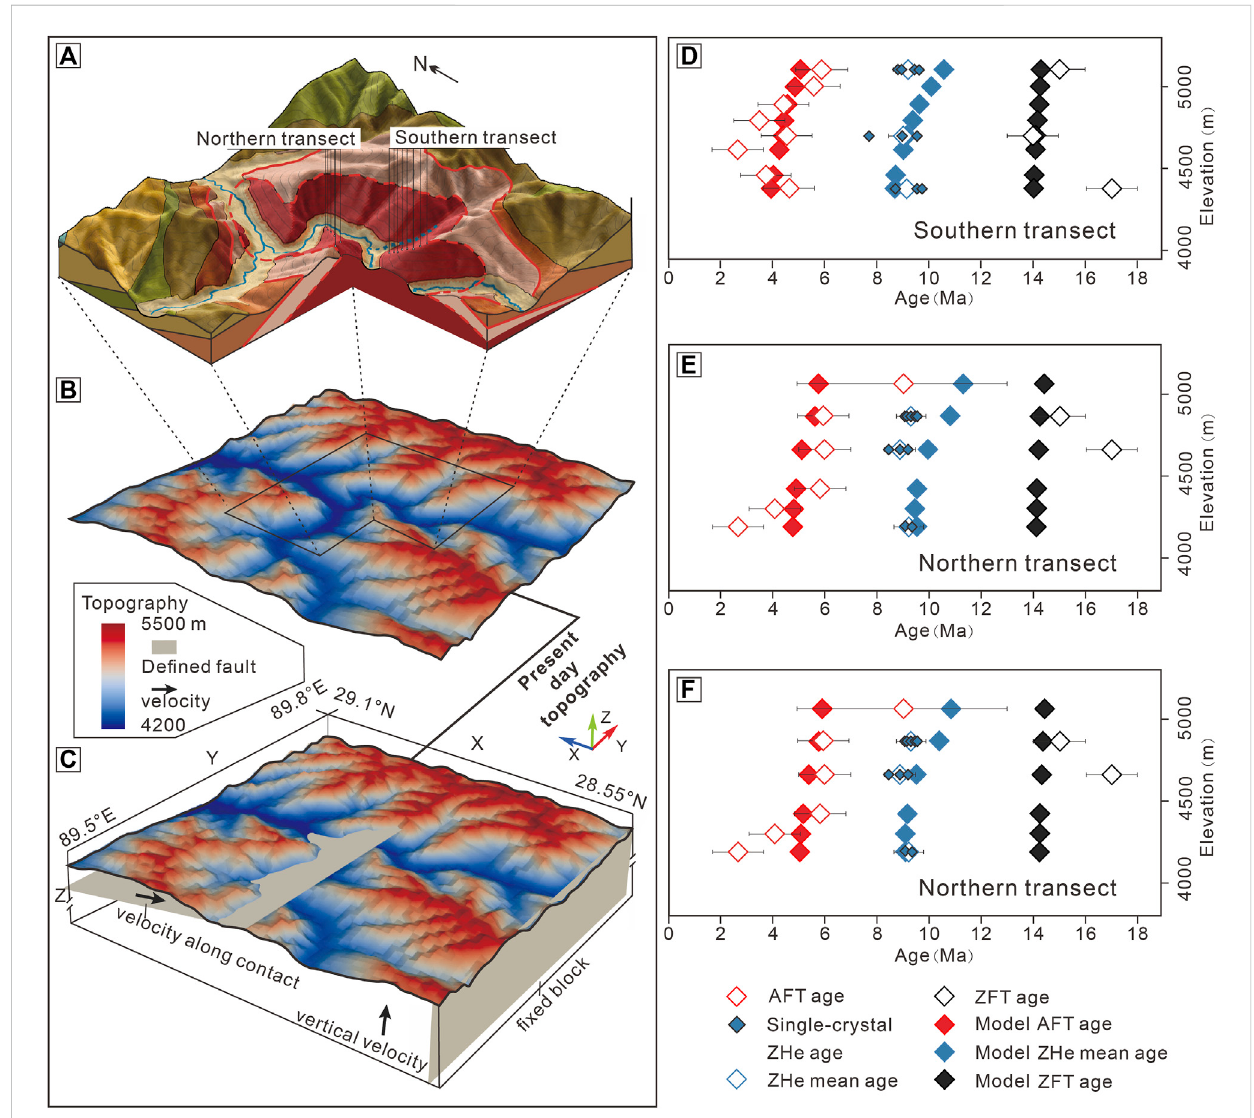
FIGURE 7 (A) Location of the two elevationtransects (Refer to Figure 3A legend for details); (B) Exhumation scenario and (C) Fault-exhumationscenario setup for the 3-D thermokinematic modeling (parameters are given in Supplementary Table S1). Measured and modeled age-elevation relationship of the southern (D) and northern (E) transects in Exhumation scenario, (F) northern transect in Fault-exhumation